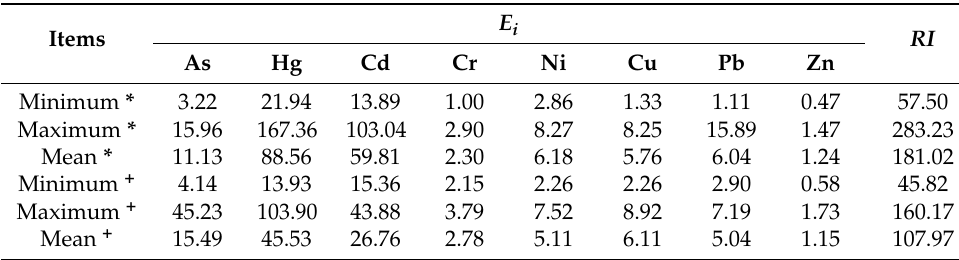
Table 3. Calculation results of the potential ecological index in the surface sediments and sediment core of Chagan Lake.